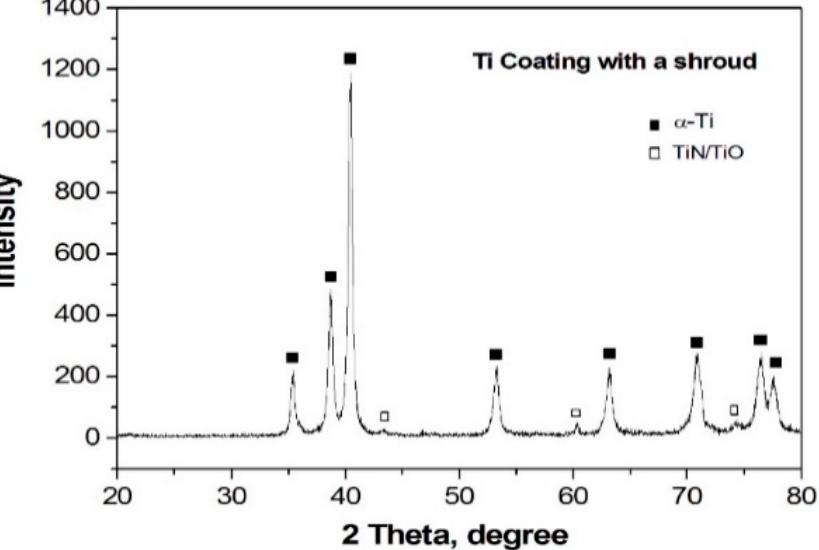
Figure 6. XRD pattern in the range of 2 θ = 20°–80° of the titanium coatings plasma-sprayed using the shroud.